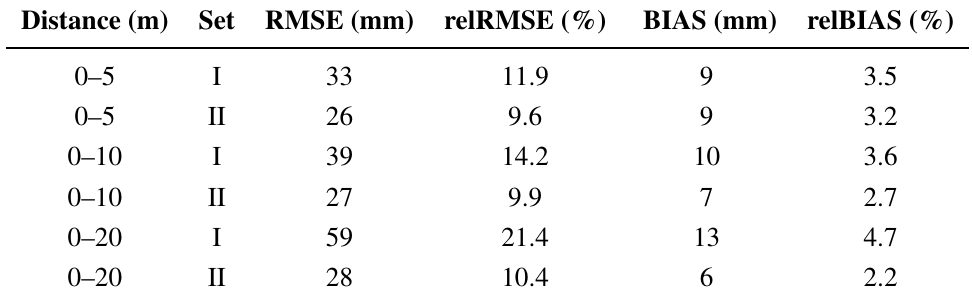
Table 3. Stem diameter estimates at different distances, (I) complete dataset, and (II) dataset with the outliers